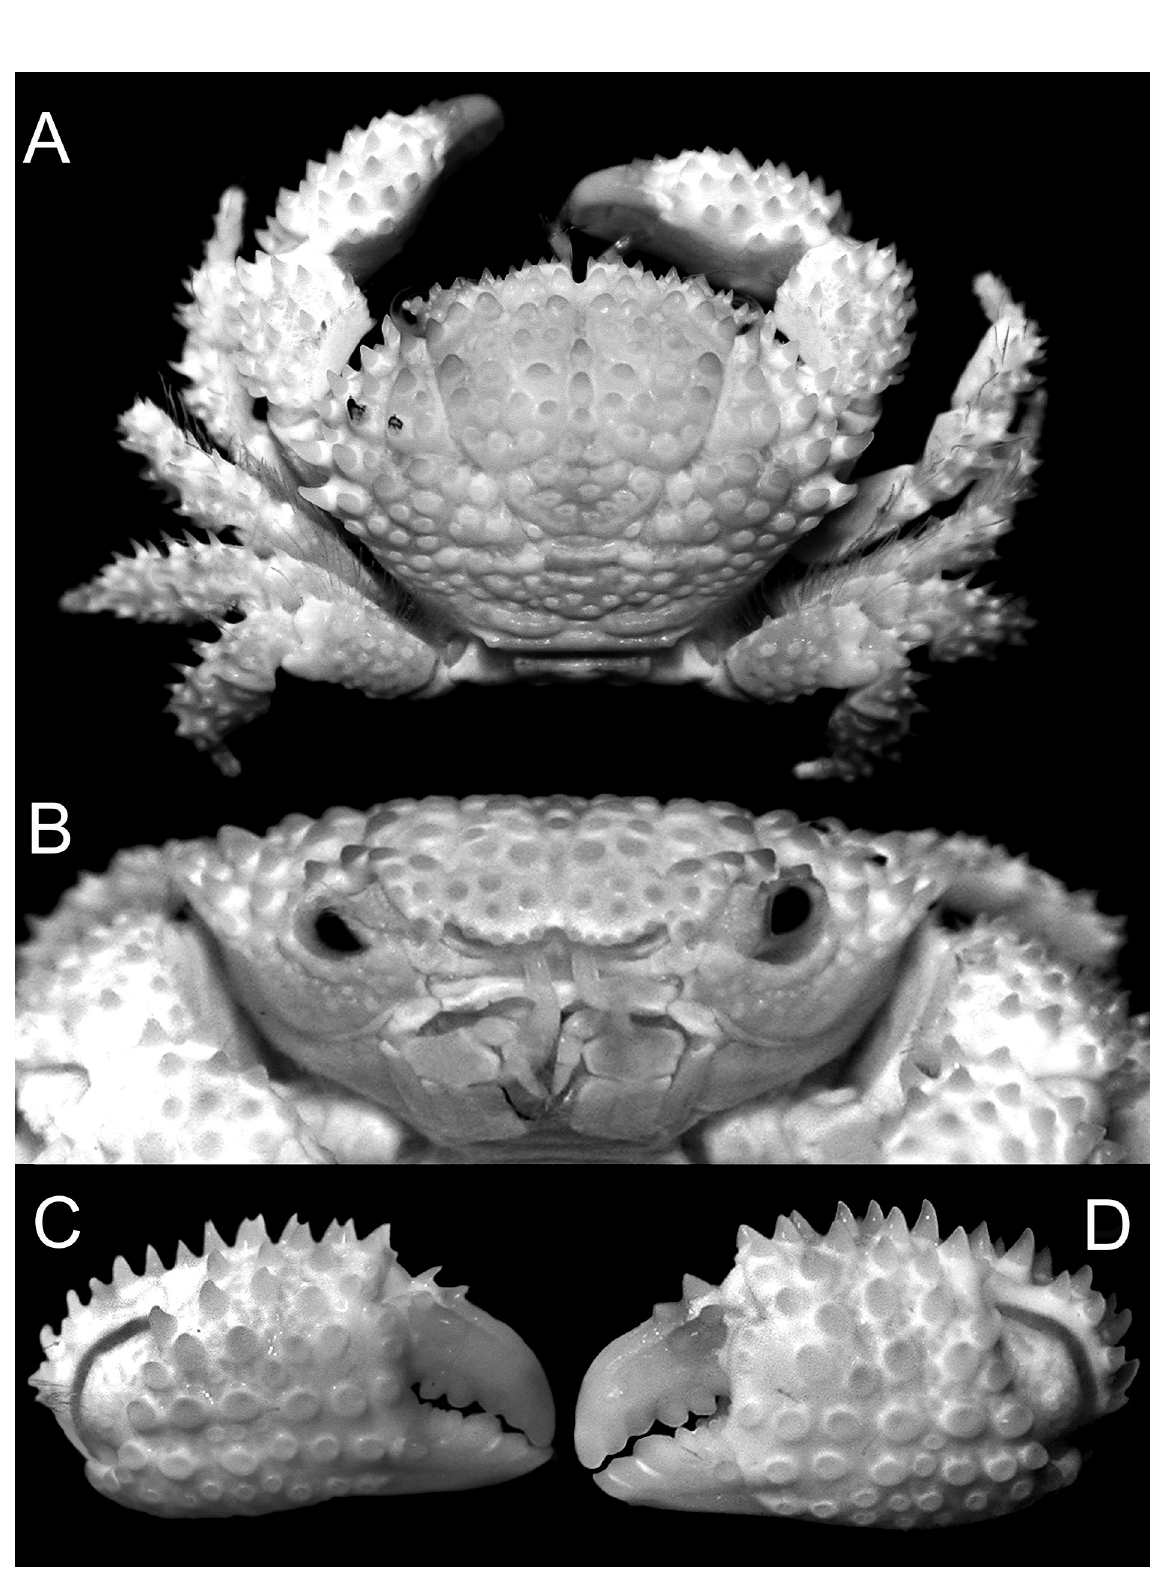
Fig. 8. Actaea spinosissima Borradaile, 1902, ♂, 8.9 × 6.6 mm (ZRC), Chagos Islands A . Dorsal view of habitus. B . Frontal view of carapace. C . Outer view of right chela. D . Outer view of left